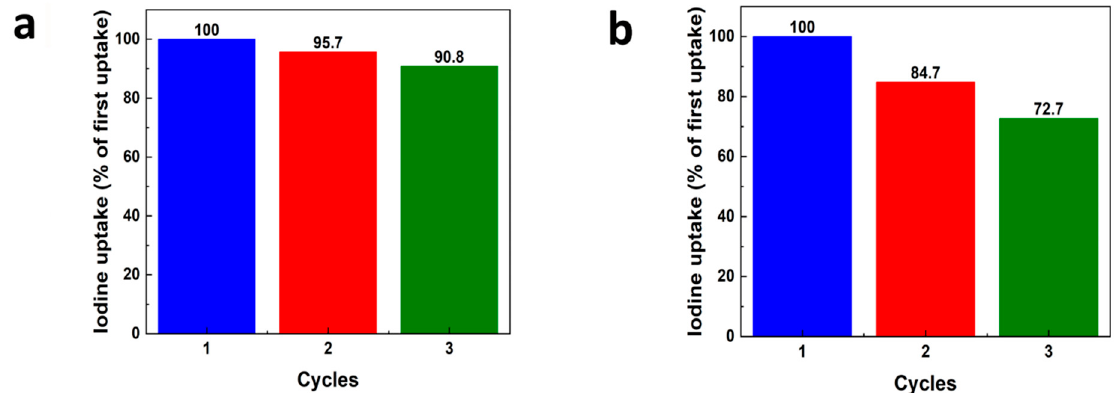
Figure 5. I 2 uptakes compared to the first cycle for ( a ) UiO-66 and ( b ) UiO-66-FA. First cycle (blue), second cycle (red) and third cycle (green). PXRD of samples after I 2 desorption are shown in Figures S7 and S8.